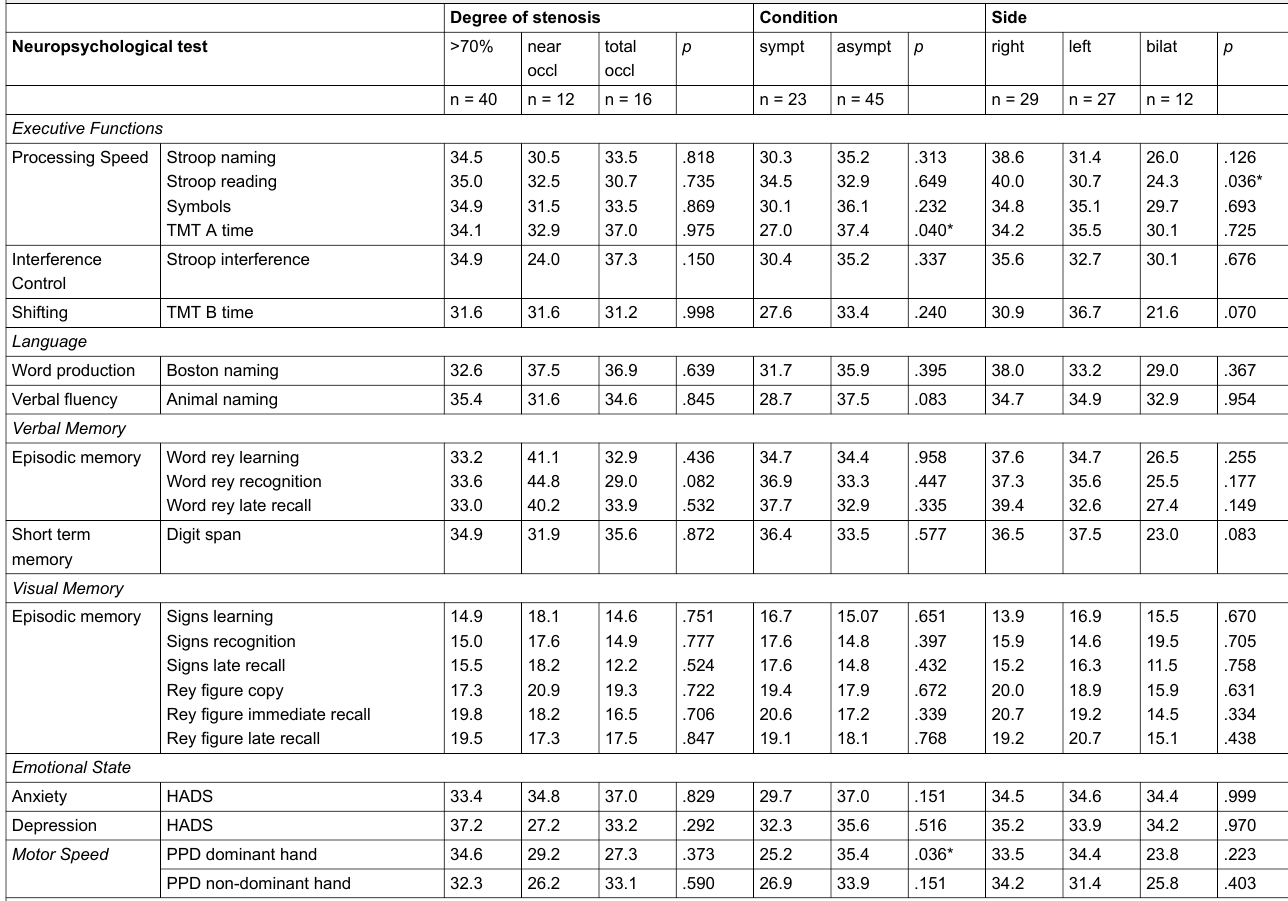
Supplementary Table : Mean Rank scores across all neuropsychological tests. Degree of stenosis